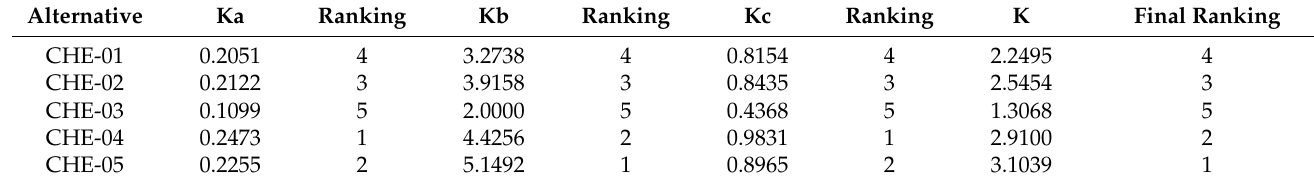
Table 12. The evaluation of the appraisal score of the CoCoSo model.